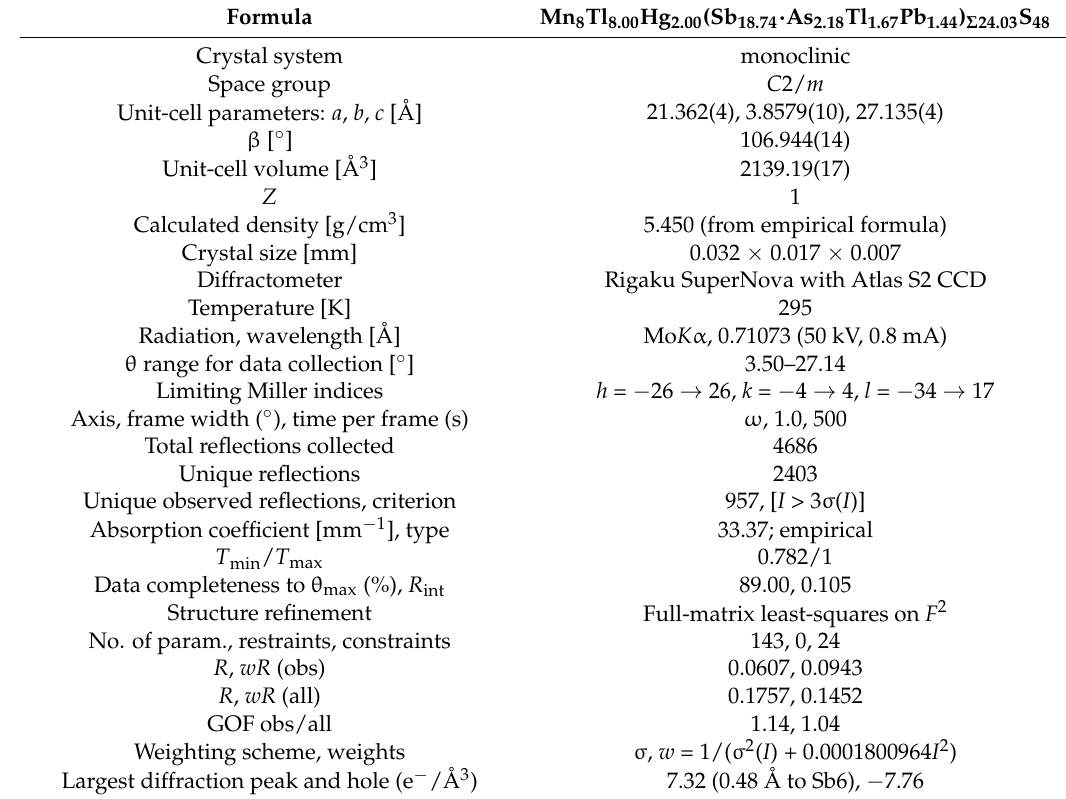
Table 4. Summary of data collection conditions and refinement parameters for